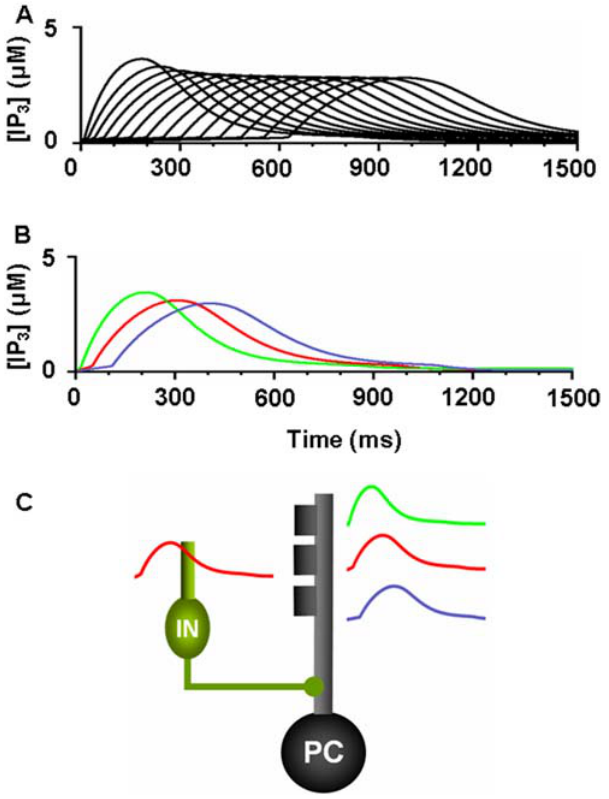
Figure 14. Distribution of IP3 activation profiles for the PC-IN population used in the model. A. IP3 activation in PC-IN population after onset of a PF signal. Each PC-IN pair is assumed to have one main time constant that generates an IP3 profile. The curves show IP3 activations by a PF signal that continued throughout the displayed time period (1500 ms). For clarity, every fourth IP3 component used in the simulation is displayed. It is assumed that the distribution of the peak time has a broad Gaussian distribution with a center around 300 ms, thus having a relatively denser representation at early timing. B. An example of one shared IP3 peak latency (in red) and two small variations (in blue and green) inside of a PC-IN pair. C. A cartoon explanation of the IP3 latencies. In this example, the PC has an IP3 peak latency of 300 ms (red) shared with the IN dendrite. A variation of IP3 peak latencies at 200 ms (green) and 400 ms (blue) are assigned to the other two spines. Note that in this example only the 300 ms peak latency is shared by the PC and IN